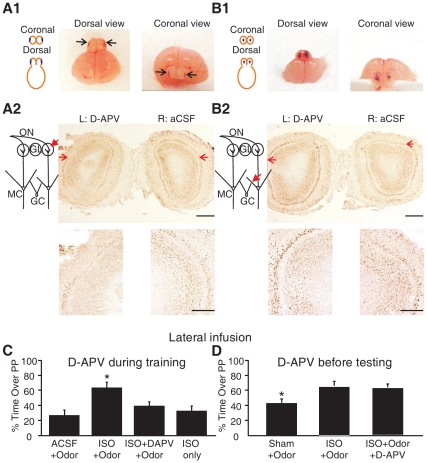
β-adrenoceptor mediated early odor preference learning was NMDAR-dependent. A1-A2.Lateral drug infusion site that selectively affects glomerular ON-MC synapses. A1
. Mid-lateral infusion sites at either coronal or horizontal views of the olfactory bulbs, infused with methylene blue dye (4%). Black arrows indicate the sites of infusions. A2
. pCREB immunohistochemistry staining shows that MC staining on the D-APV infusion site were suppressed compared to the control ACSF site, suggesting D-APV mainly acts on the ON-MC synapses in this preparation. Red arrows in the upper panel indicate the difference in pCREB staining in the lateral regions of the MC layers. Lower panel shows enlarged lateral regions of MC layers. Scale bars, 500 µm (upper panel) and 200 µm (lower panel). B1
. Central infusion sites at either coronal or horizontal views of the olfactory bulbs, B2
. pCREB immunohistochemistry staining shows that MC staining on the D-APV infusion sites was enhanced compared to the control ACSF sites, suggesting D-APV mainly acts on the GC-MC synapses in this preparation. Same labeling and enlargement were used as in A2. C
. Early odor preference learning is blocked when an NMDAR antagonist D-APV is infused during training. Bars show the percentage of time spent in the peppermint side of a two-choice test box across different experimental groups. *p<0.05. Error bars, mean±SEM. D. D-APV infusion 10 min before testing does not prevent the odor preference formed with ISO+Odor pairing. *p<0.05. Error bars, mean±SEM.